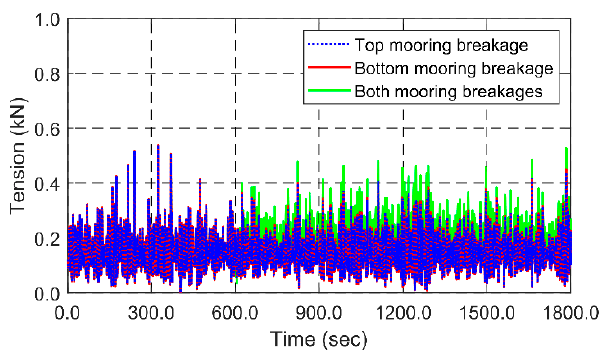
Figure 16. Time histories of the mooring tension in the middle location (Y = 0 m) as mooring lines at Y = − 50 m are broken after 600 s ( H s = 2.0 m, T p = 7.0 s, current velocity = 0.6 m/s).